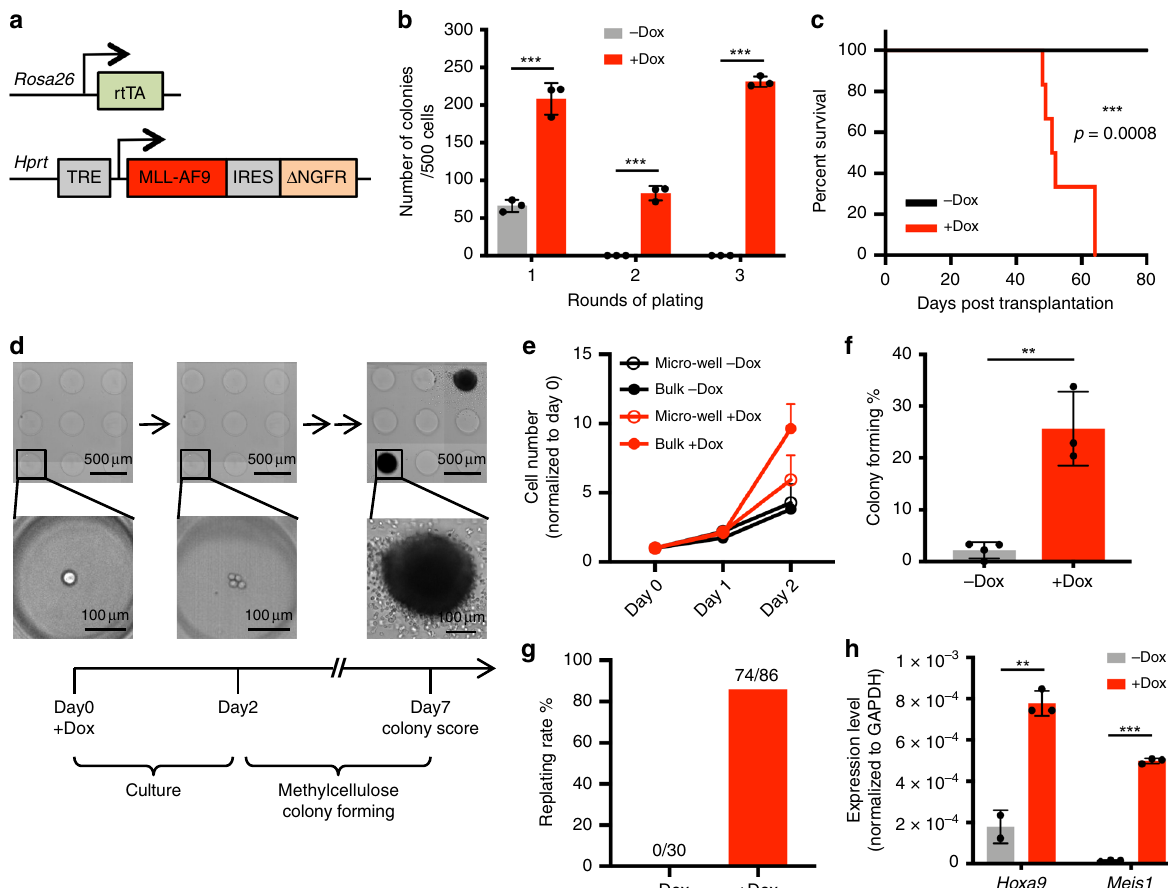
Fig. 1 Tracking MLL-AF9-mediated transformation from single hematopoietic cells. a Schema of the inducible MLL-AF9-IRES- Δ NGFR allele targeted into the endogenous Hprt locus. b Dox-dependent serial colony formation by iMLL-AF9 GMPs; n = 3 for both conditions, p < 0.001 for all comparisons. c Kaplan – Meier curve of cohorts of mice transplanted with 12,000 iMLL-AF9 GMPs, fed with control or Dox water ( n = 6 for each group). AML pathology was con fi rmed and shown in Supplementary Fig. 2a – d. p = 0.0008 as calculated by log-rank (Mantel – Cox) test. d Representative images tracking single GMPs and their progeny in micro-wells. Cells in micro-wells were kept in liquid culture for 2 days, after which the medium was replaced by methylcellulose represent 500 μ m for upper panels, and 100 μ m for lower panels. e Comparison of iMLL-AF9 GMP proliferation rates in micro-wells and in bulk culture. f Colony forming ef fi ciencies from single iMLL-AF9 GMPs following the schema in d . The presence of single cells was con fi rmed at day 0; n = 4 for − Dox, n